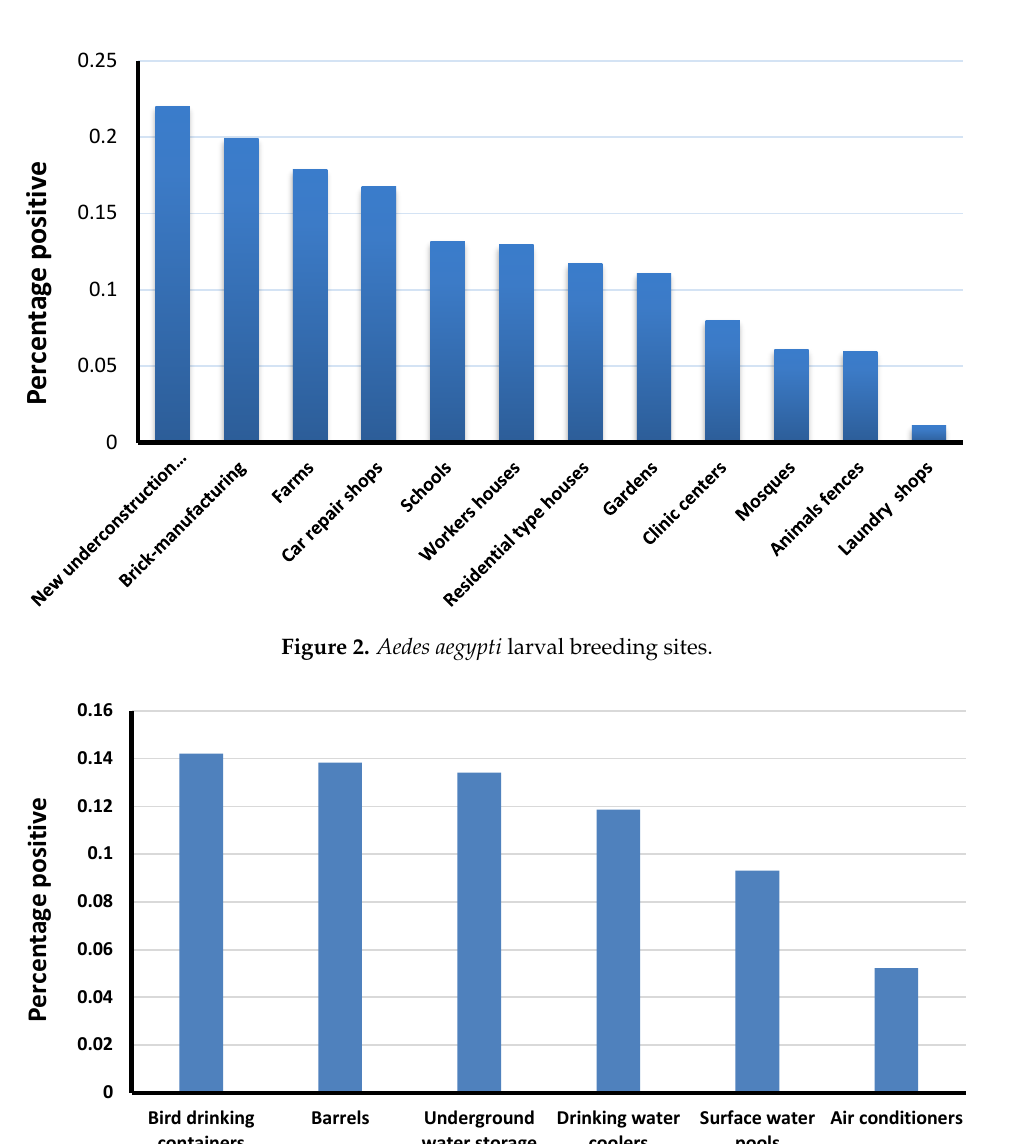
Figure 1. Field photos and examples of potential breeding sites for Aedes aegypti . ( a ) Construction site, ( b ) uncovered water tanks, ( c ) air conditioner, and ( d ) bird drinking containers.